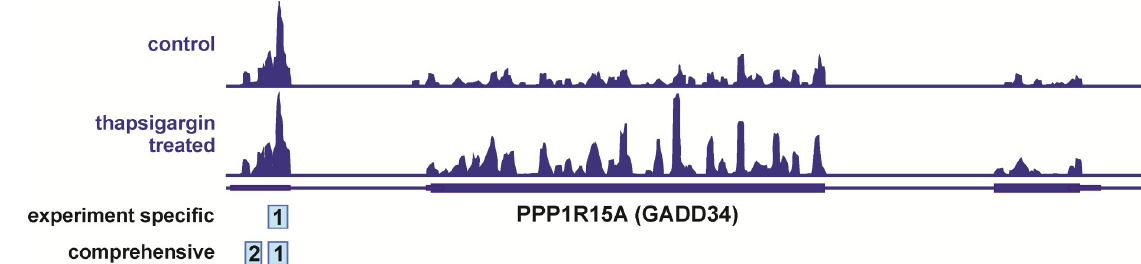
Fig 3. Distribution of RPF reads on the PPP1R15A (GADD34) transcript. Reads of control ( upper panel ) or thapsigargin-treated ( lower panel ) HEK293 from data set GSE103719 are shown. uORFs annotated either in the experiment-specific (1) or the comprehensive annotation file (1 and 2) within uORF-Tools are marked.